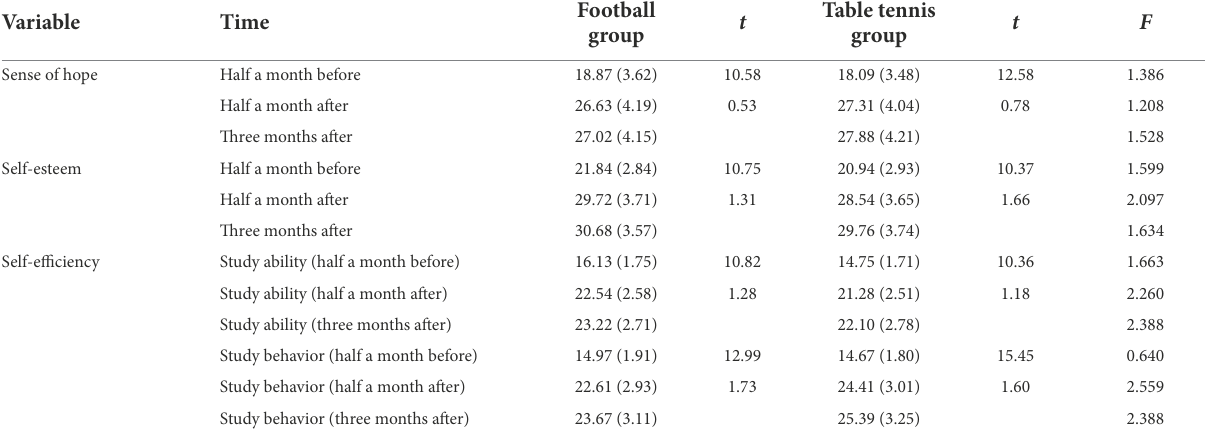
Football Table tennis t group